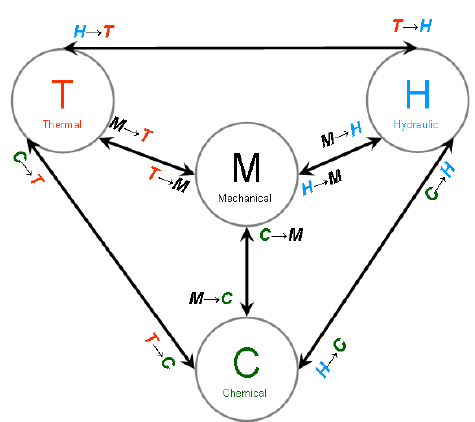
Figure 3. Conceptual model of thermo-hydro-mechanical-chemical (THMC)-coupled processes by the developed simulator.